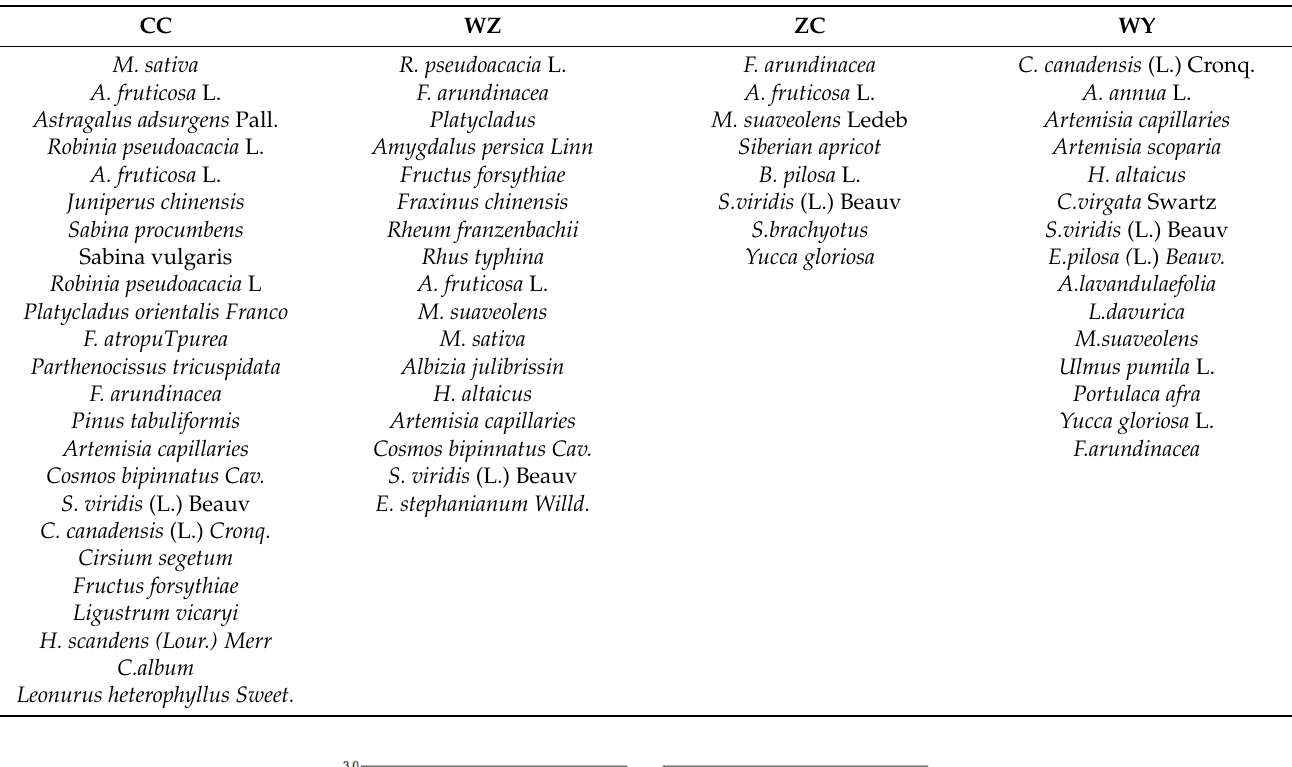
Table 2. Vegetation diversity in the study area.